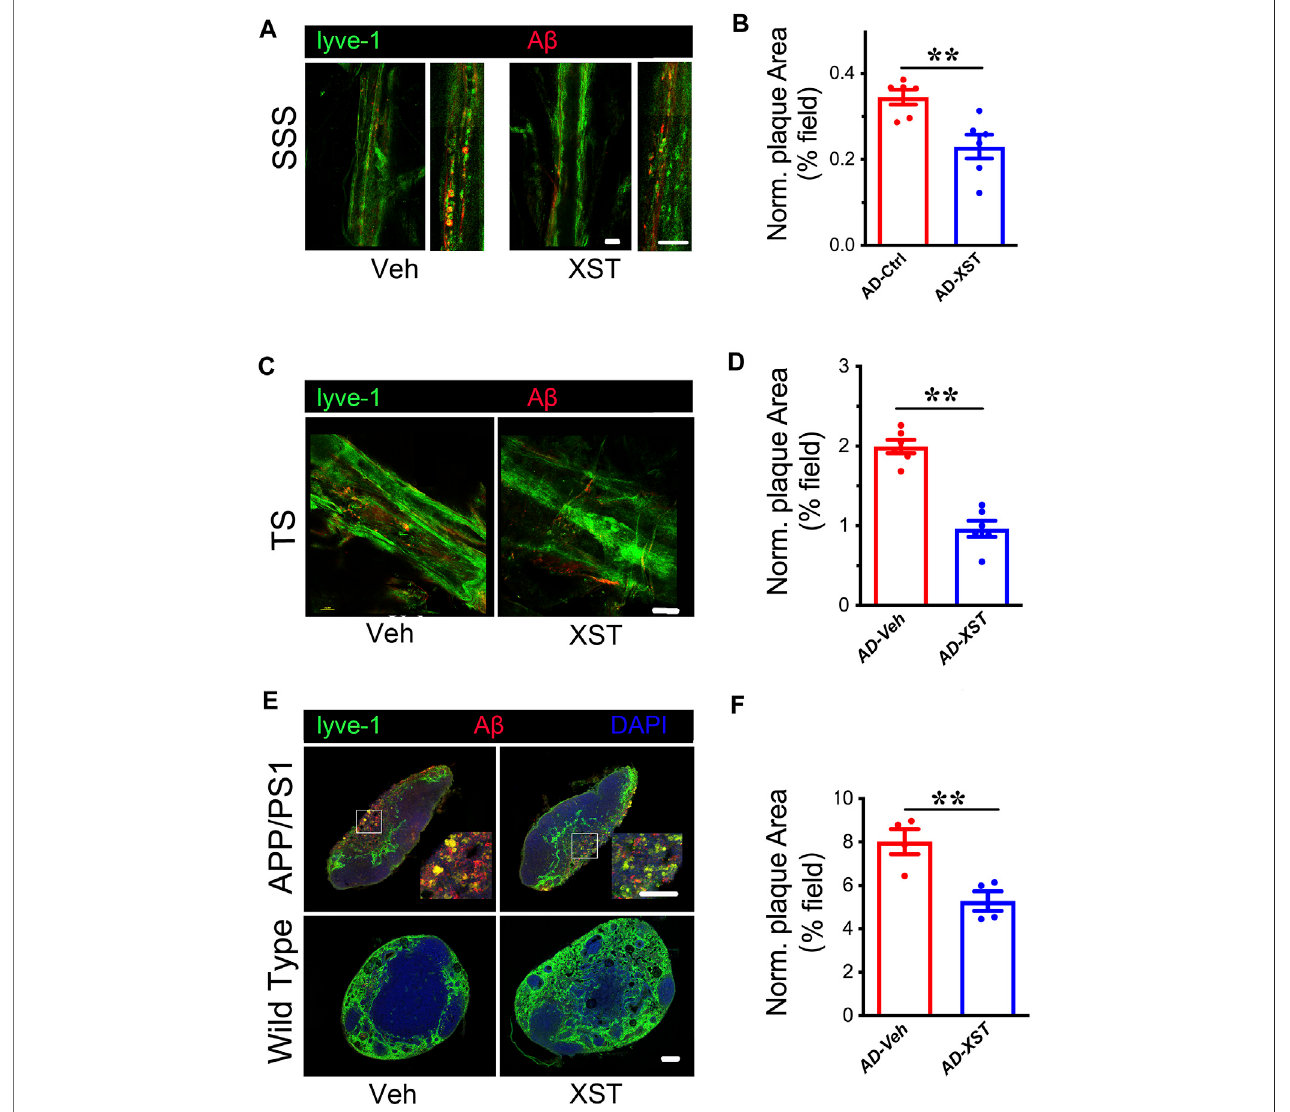
FIGURE 2 | XST improves A β removal from brains of APP/PS1 mice. (A) Impact of XST on the removal of A β via the brain lymphatic ducts in APP/PS1 mice, in the SSSandTSregions.Red,A β ;green,Lyve-1.Scalebars,100 μ m. (B) Quanti fi cationofplaqueareaintheSSSregioninXST-orVeh-treatedgroup( p (cid:2) 0.0056, t -test, n (cid:2) 6 mice per group). (C) Impact of XST on A β removal via the brain lymphatic ducts in APP/PS1 mice, in the TS regions. Red, A β ; green, Lyve-1. Scale bar, 100 μ m. (D) Quanti fi cation of plaque area in the TS region XST- or Veh-treated group ( p (cid:2) 0.0067, t -test, n (cid:2) 4 mice per group). (E) Sample images if A β staining in the lymph nodesoftheneck.Red,A β ;green,Lyve-1;blue,DAPI.Scalebar,200 μ m(low).Scalebar,100 μ m(high). (F) Quanti fi cationofplaqueareainthelymphnodesoftheneck region in XST- or Veh-treated APP/PS1 mice ( p (cid:2) 0.0098, t -test, n (cid:2) 4 mice per group). Data are mean ± SEM. * p < 0.05; ** p < 0.01.